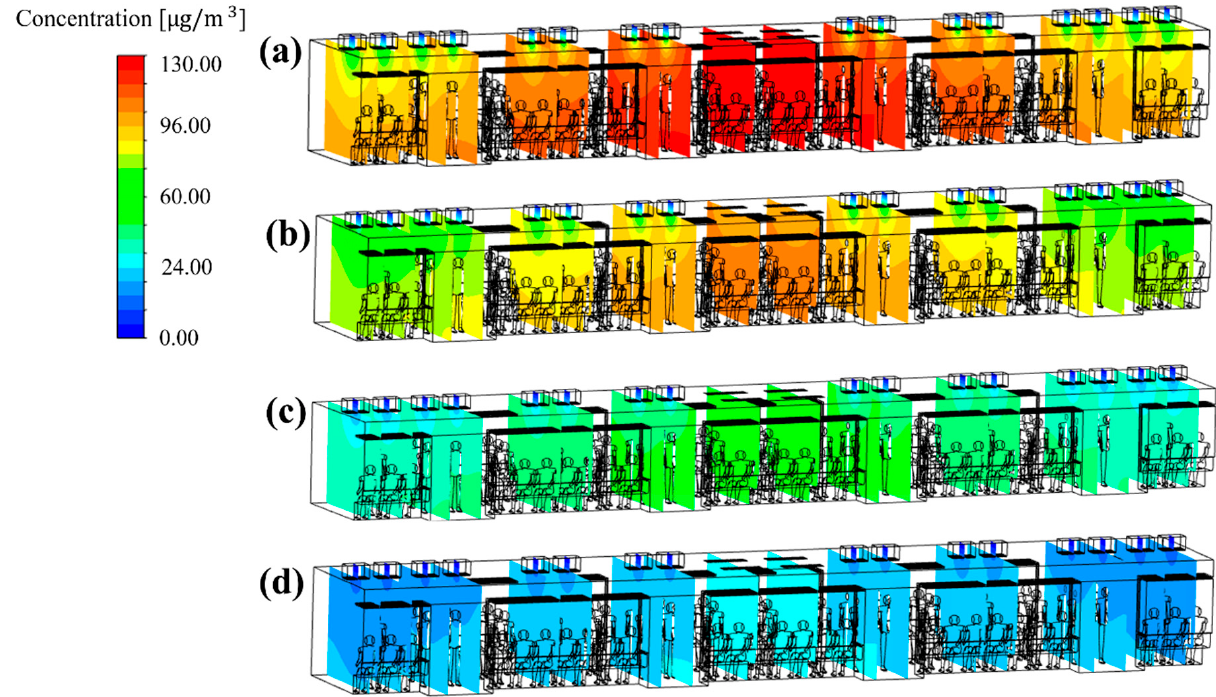
Figure 6. PM 10 concentration distribution inside the subway cabin according to the efficiency of filters used in the HVAC system (total ventilation flow rate: 500 CMH): ( a ) 70% (case 1); ( b ) 80% (case 2); ( c ) 85% (case 3); and ( d ) 90% (case 4).